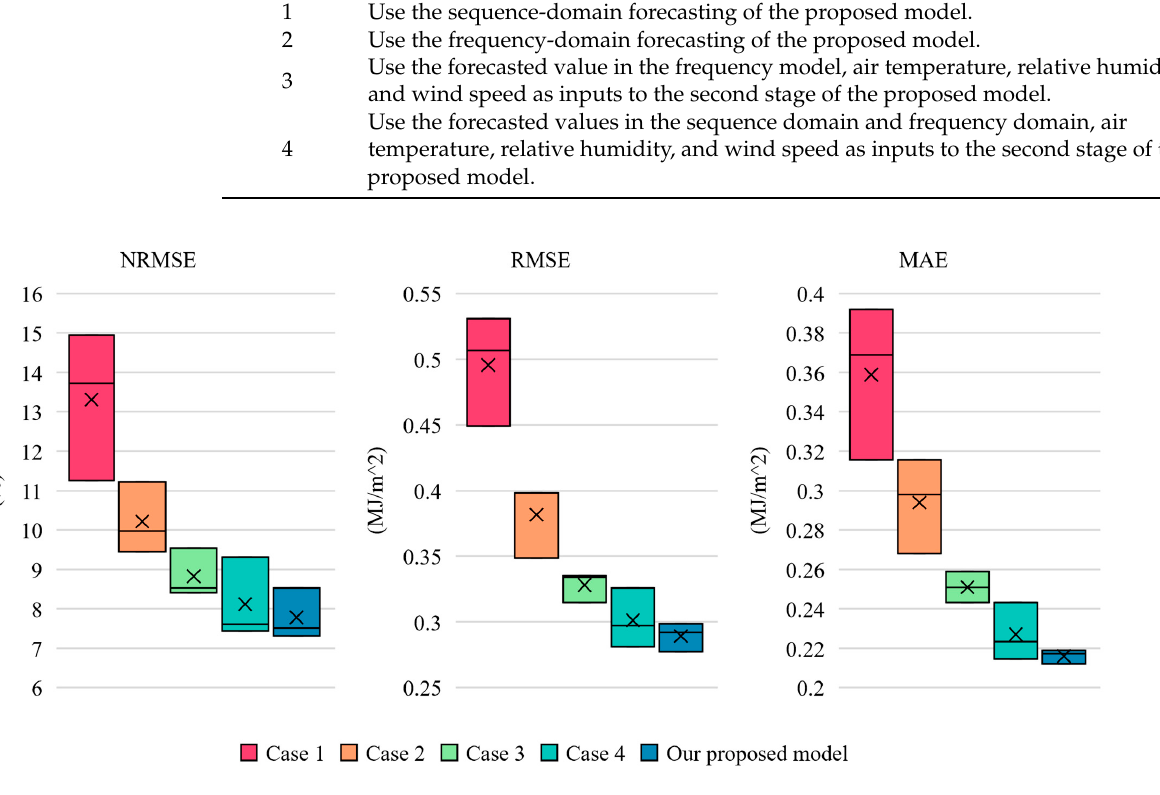
Figure 11. Ablation study result.